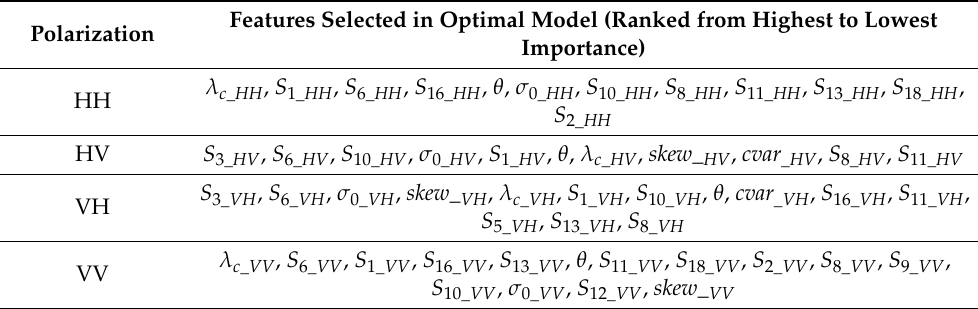
Table A1. The optimal features used in different polarization